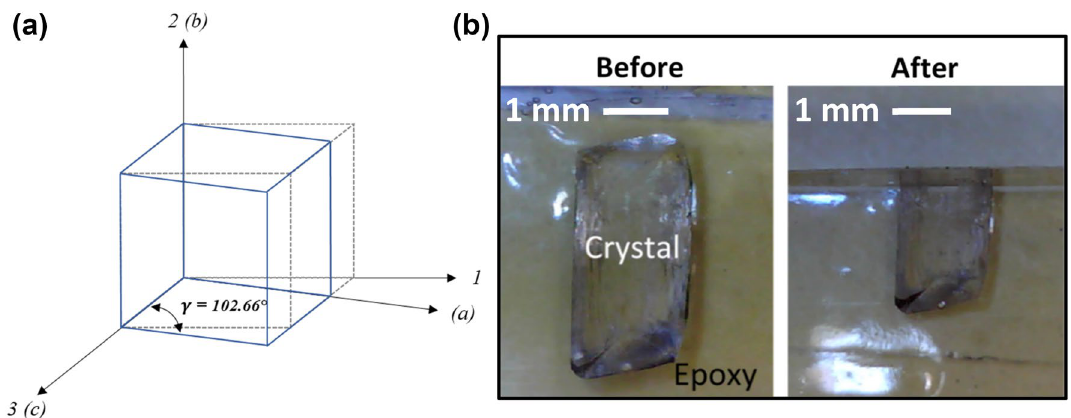
Fig. 2 a Crystallographic axes and planes of monoclinic β-HMX. b Before and after images showing cleaving of embedded β-HMX crystal to expose (100)